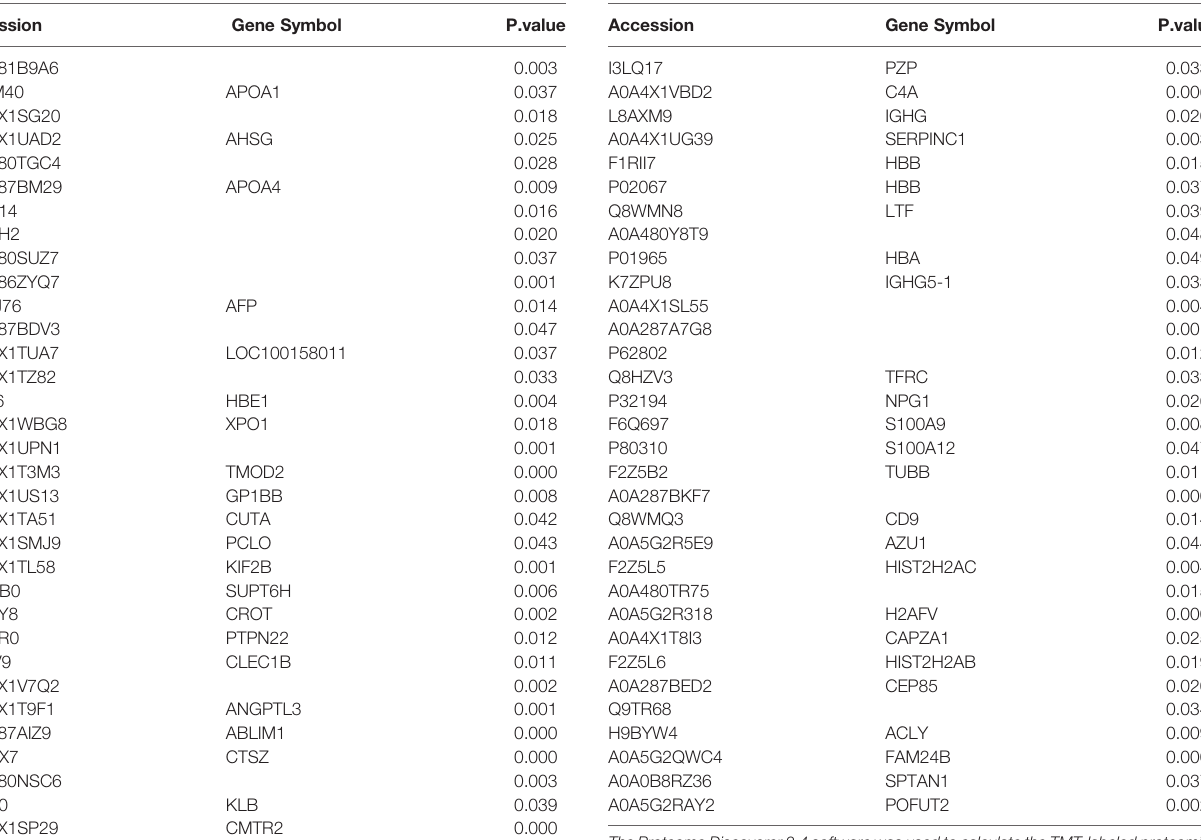
TABLE 2 | Signi fi cantly up-regulated proteins in